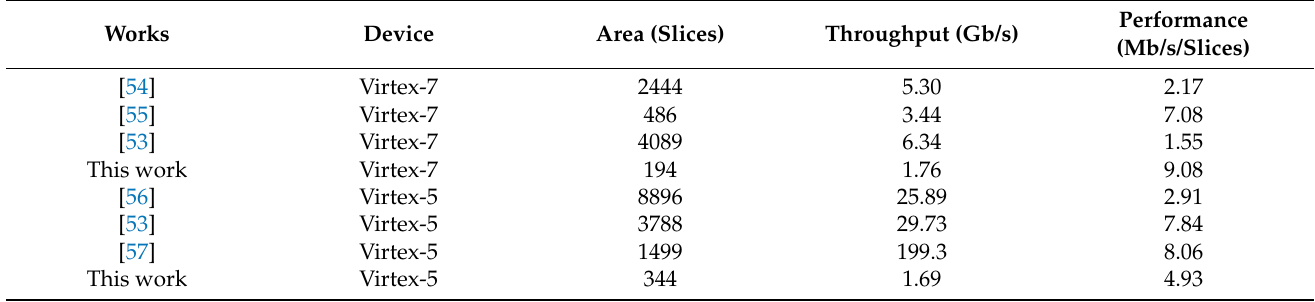
Table 5. AES implementation results